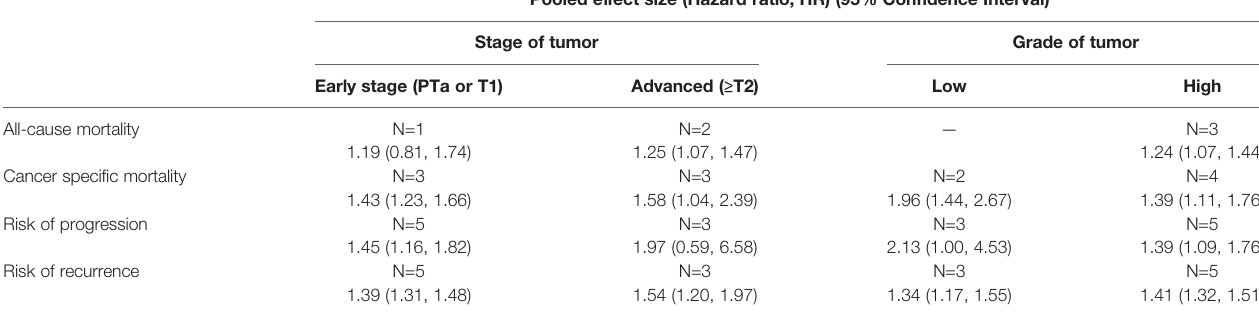
TABLE 1 | Subgroup analysis for diabetes as a bladder cancer risk